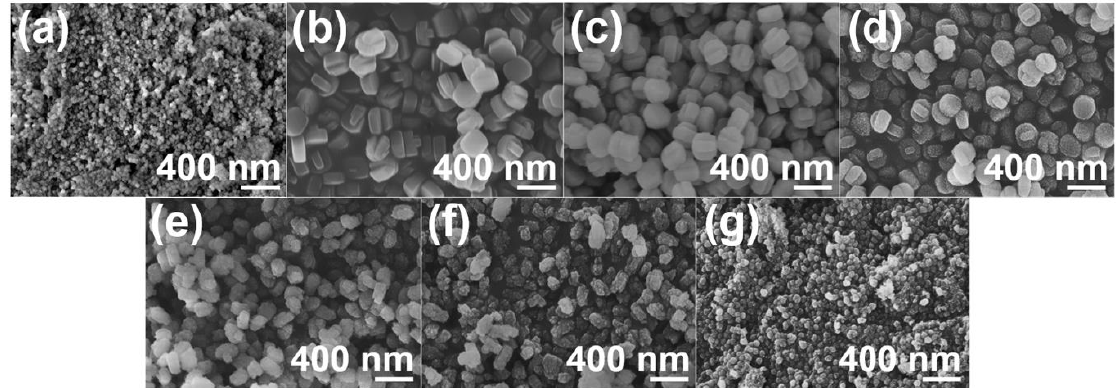
Figure 2. Zeolite synthesized in the presence of silicalite-1 seed. SEM imagery of ( a ) silicalite-1 seed crystals; and ( b – g ) seeded grown Al-ZSM-5 zeolites with different SARs. SEM imagery of the zeolites synthesized with sol compositions of ( b ) SAR = ∞; ( c ) SAR = 140; ( d ) SAR = 70; ( e ) SAR = 40; ( f ) SAR = 35; and ( g ) SAR = 25. The sol composition was 4050 H 2 O:4.5 TPAOH:20 SiO 2 :x Al 2 O 3 :2x NaOH, where x = 0, 0.07, 0.15, 0.25, 0.29, and 0.63, following the addition of silicalite-1 seeds (3.62 × 10 − 2 wt%: the weight ratio of silicalite-1 nanocrystals and TEOS). The synthesis was conducted at 150 ◦ C for 24 h. Table 1. Weight and number of particles of the zeolites with different SARs *. Catalyst